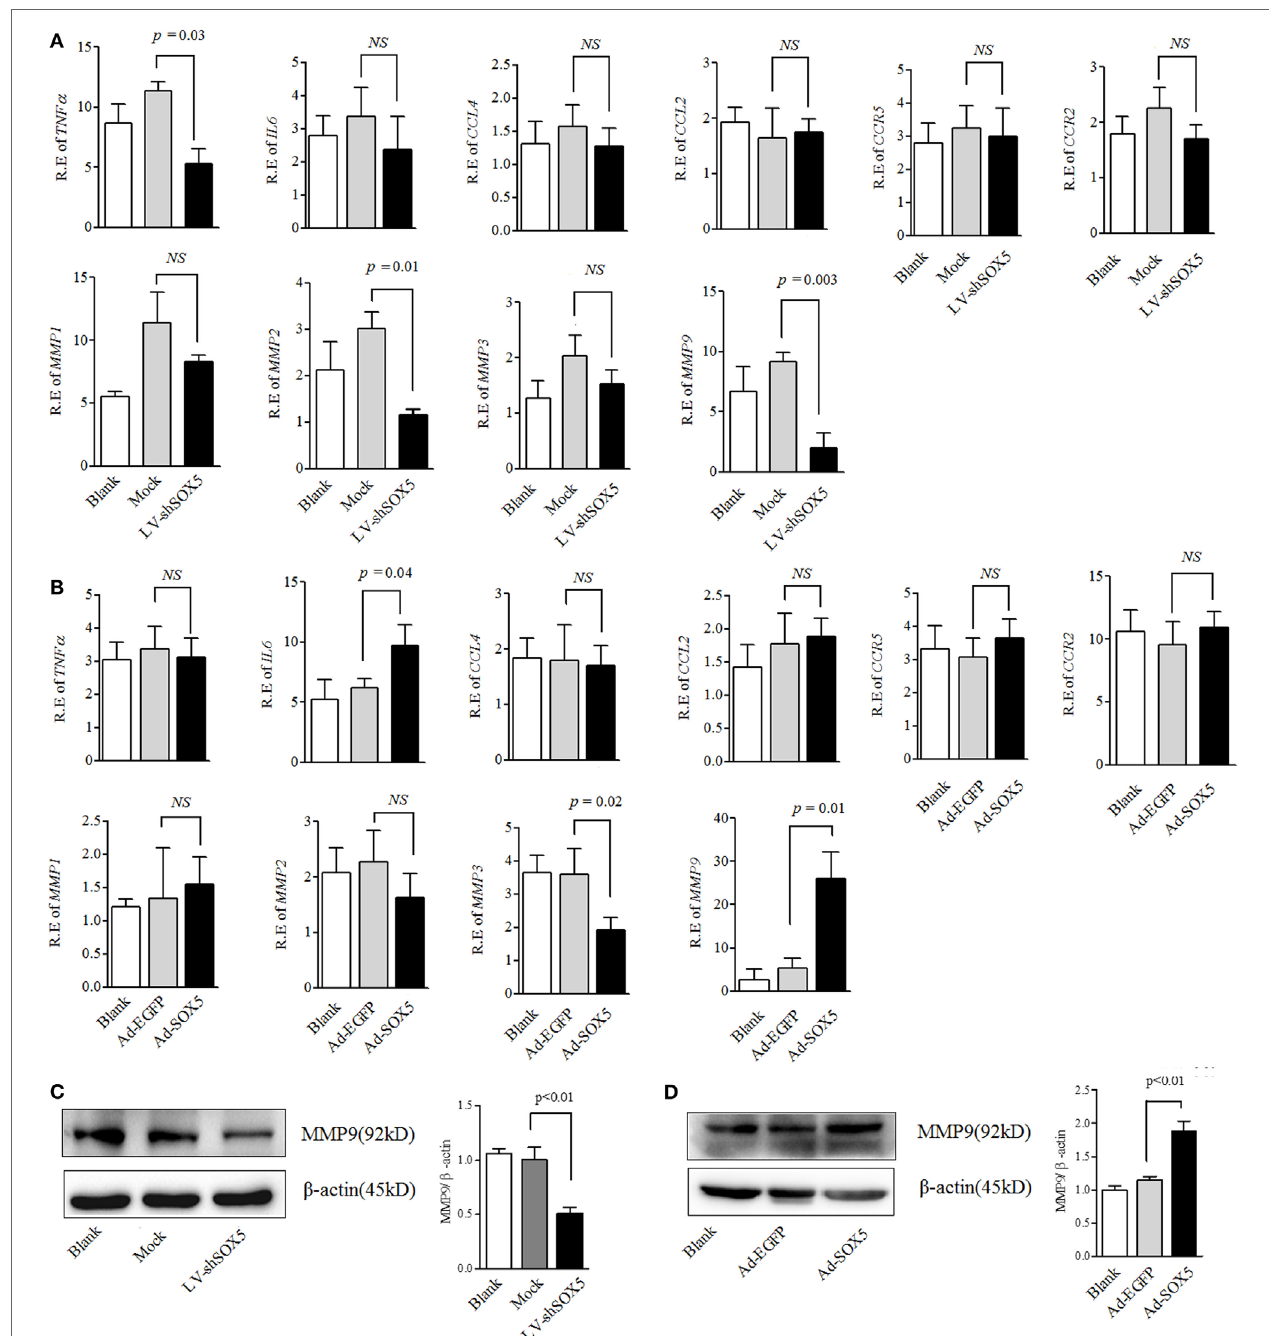
FigUre 2 | SOX5-mediated RA-FLS migration and invasion by regulating MMP-9 expression. (a) Following knockdown SOX5 in fibroblast-like synoviocytes (FLS) for 96 h by transfection with LV-shSOX5 or Mock vector, expression of TNF- α , IL-6, CCL4, CCL2, matrix metalloproteinase (MMP)-1, 2, 3, and 9 were detected by real-time PCR. (B) Following overexpressing SOX5 in FLS for 72 h by transfection with Ad-SOX5 or Ad-EGFP, expression of TNF- α , IL-6, CCL4, CCL2, MMP-1, 2, 3, and 9 were detected by real-time PCR. (c,D) Protein levels of MMP-9 in SOX5 knockdown (c) and overexpressing (D) FLS. Data are each representative of three independent experiments in different FLS lines ( n =